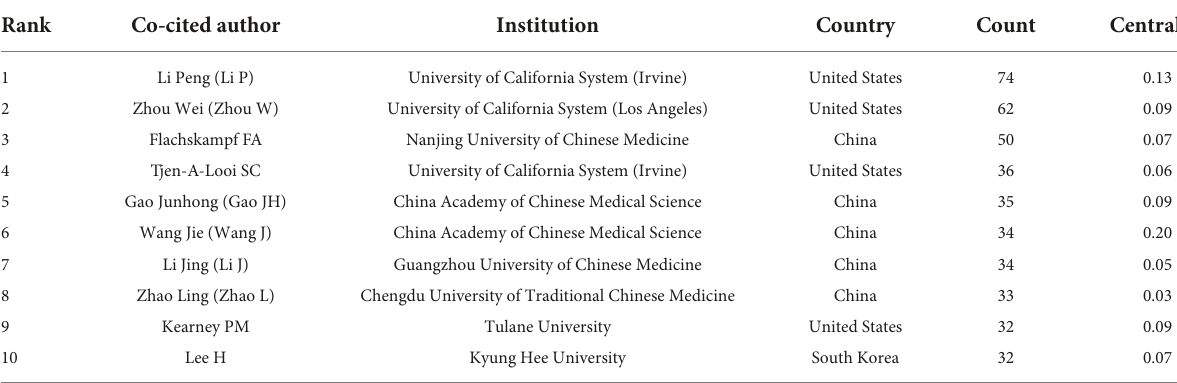
TABLE 4b The top 10 co-cited